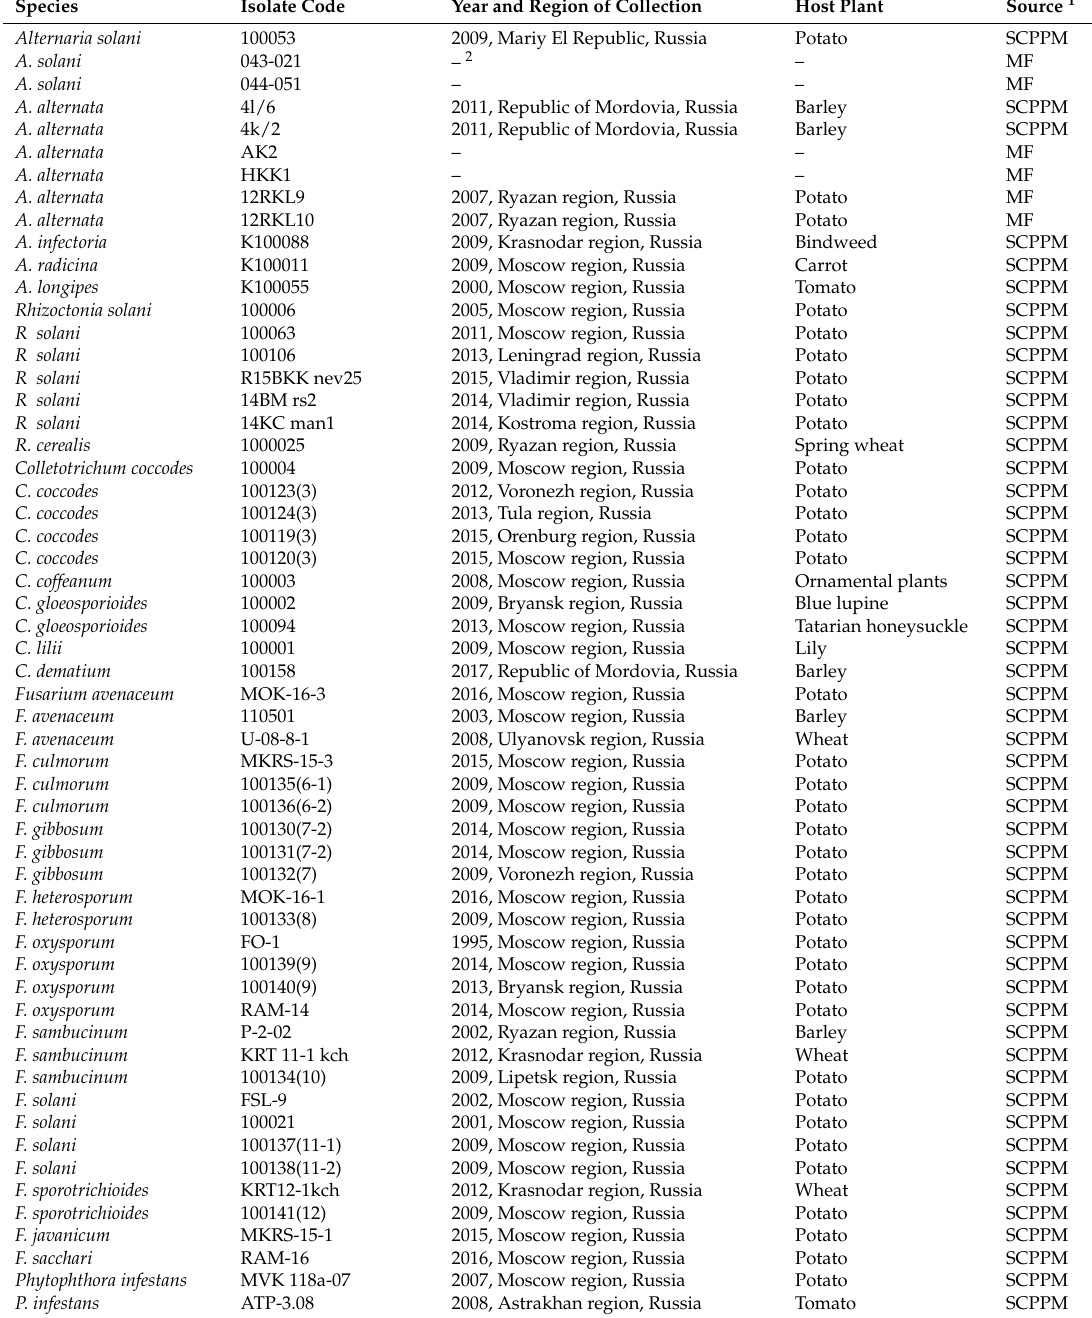
Table 1. Fungal isolates used in this